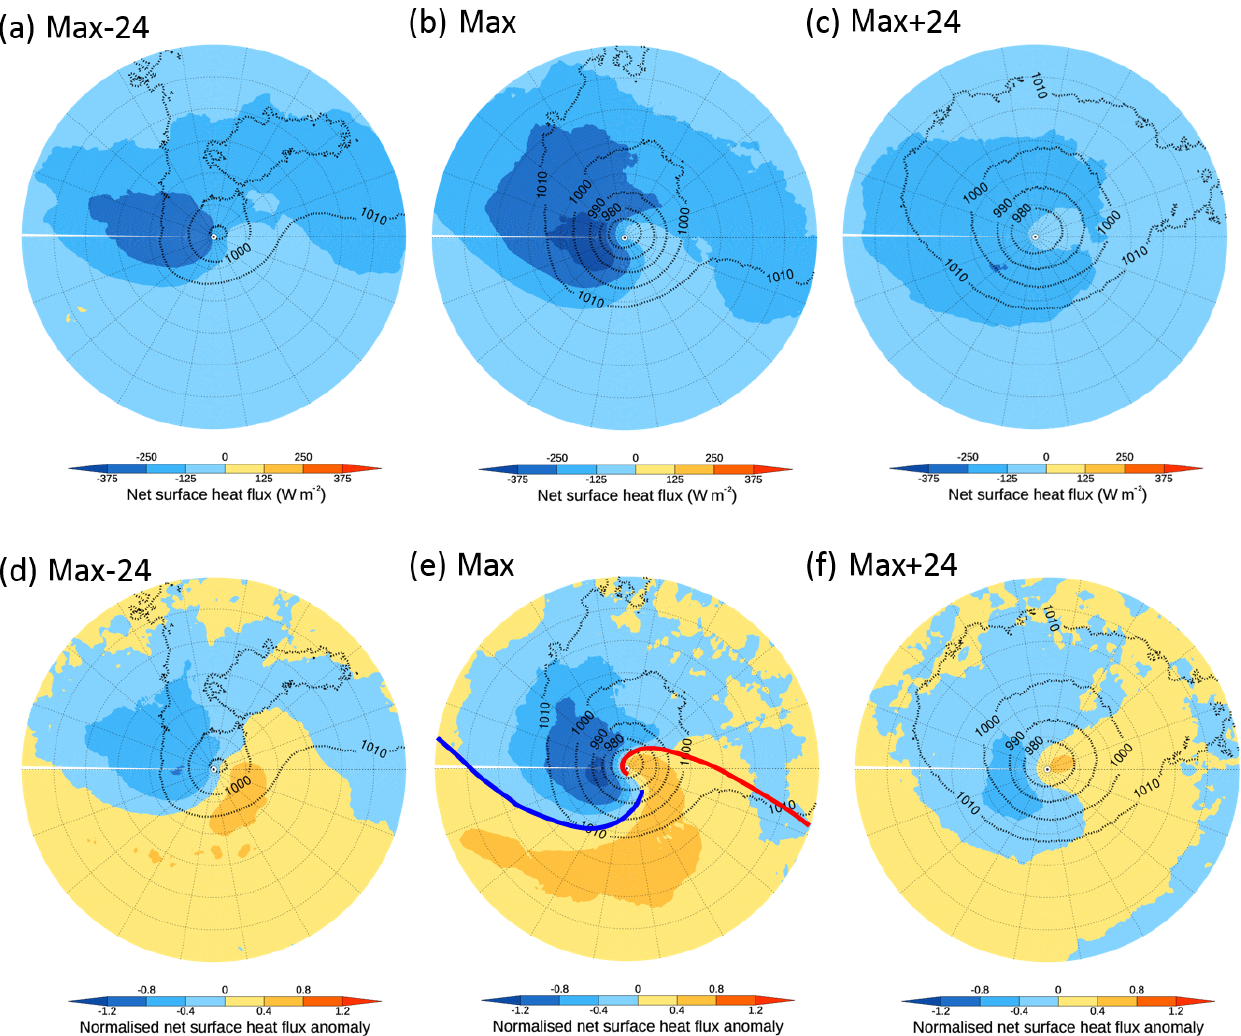
Figure 7. Evolution of cyclone-centred (a–c) net surface heat flux Q N (filled contours, Wm − 2 ), (d–f) normalized net heat flux anomaly (filled contours) and mslp (black contours; hPa). Cyclones reach the centre of the domain (a, d) 24h before maximum intensity, (b, e) at maximum intensity and (c, f) 24h after maximum intensity. In (d) – (f) negative normalized heat flux anomalies indicate anomalously large heat flux into the atmosphere, and positive anomalies indicate anomalously small heat flux into the atmosphere, compared to climatology. The blue and red lines in (e) represent the approximate positions of the cold and warm fronts at max